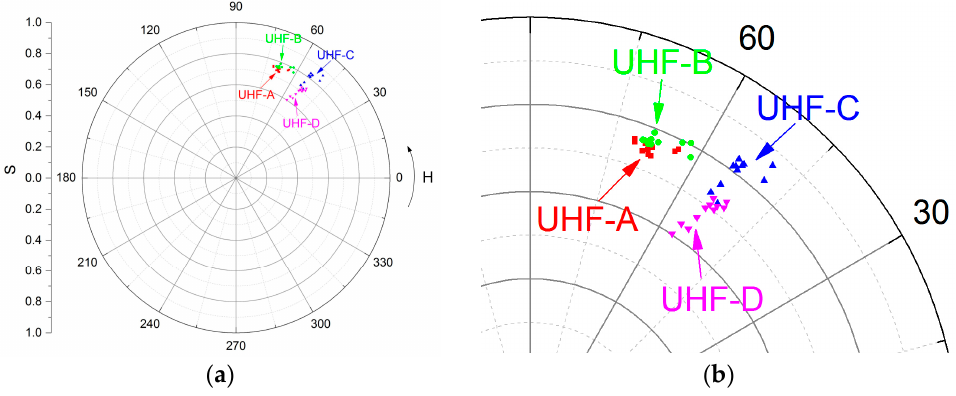
Figure 7. Distribution of 10 groups of UHF signals obtained by the four sensors in the H-S polar diagram: ( a ) global diagram; and ( b ) enlarged diagram. (UHF: ultra-high frequency).